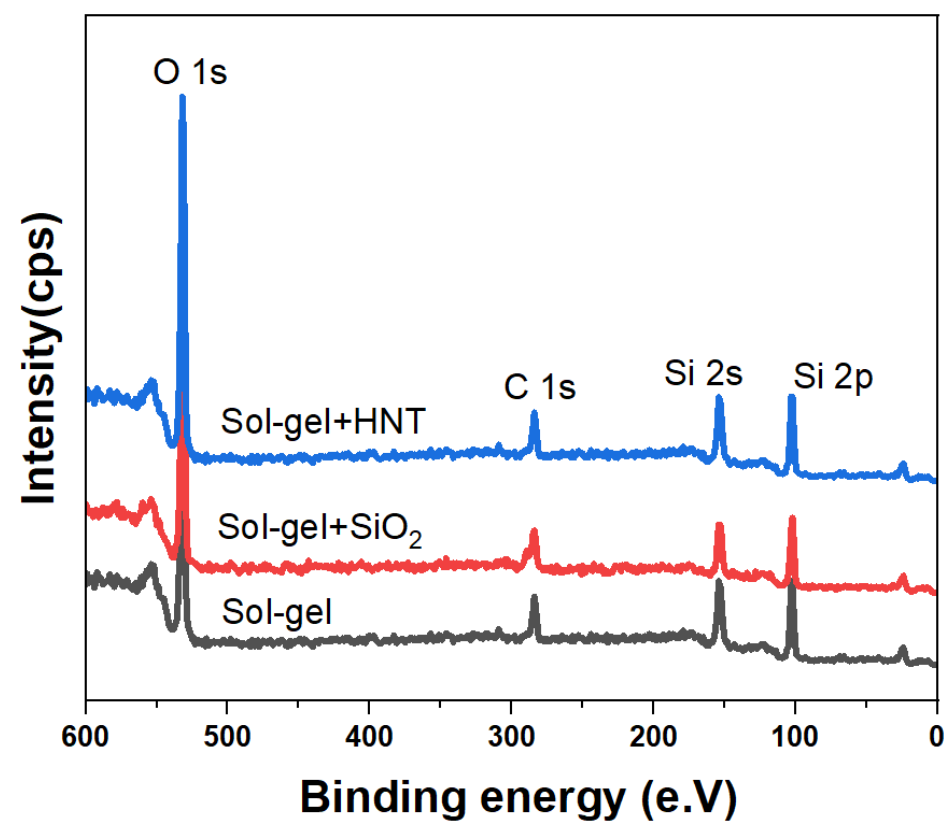
Figure 4. X-ray photoelectron spectroscopy (XPS) survey spectrum of sol–gel, sol–gel + SiO 2 , and sol–gel + HNT. Table 1. Atomic percentage determined by XPS for sol – gel, sol – gel-HNT, and sol – gel + SiO 2 .